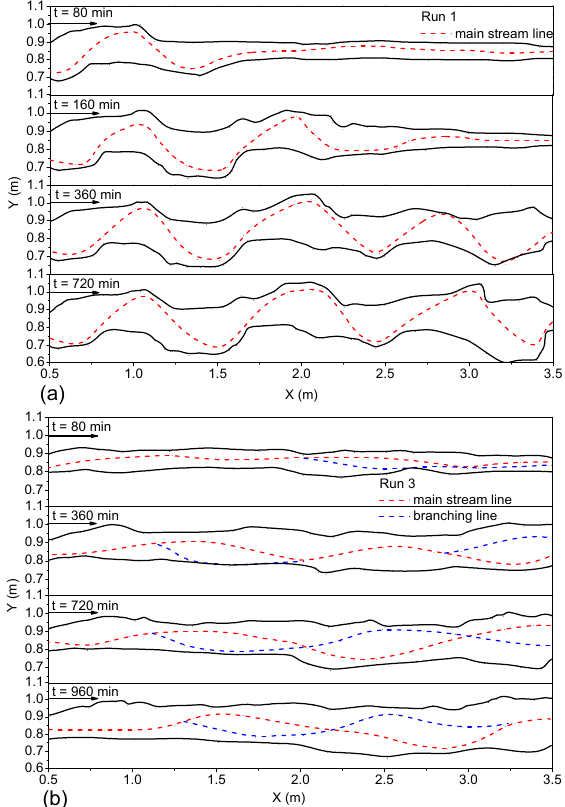
Figure 5. Dynamic axis of flow in bends under different moments: ( a ) Run 1 and ( b ) Run 3.